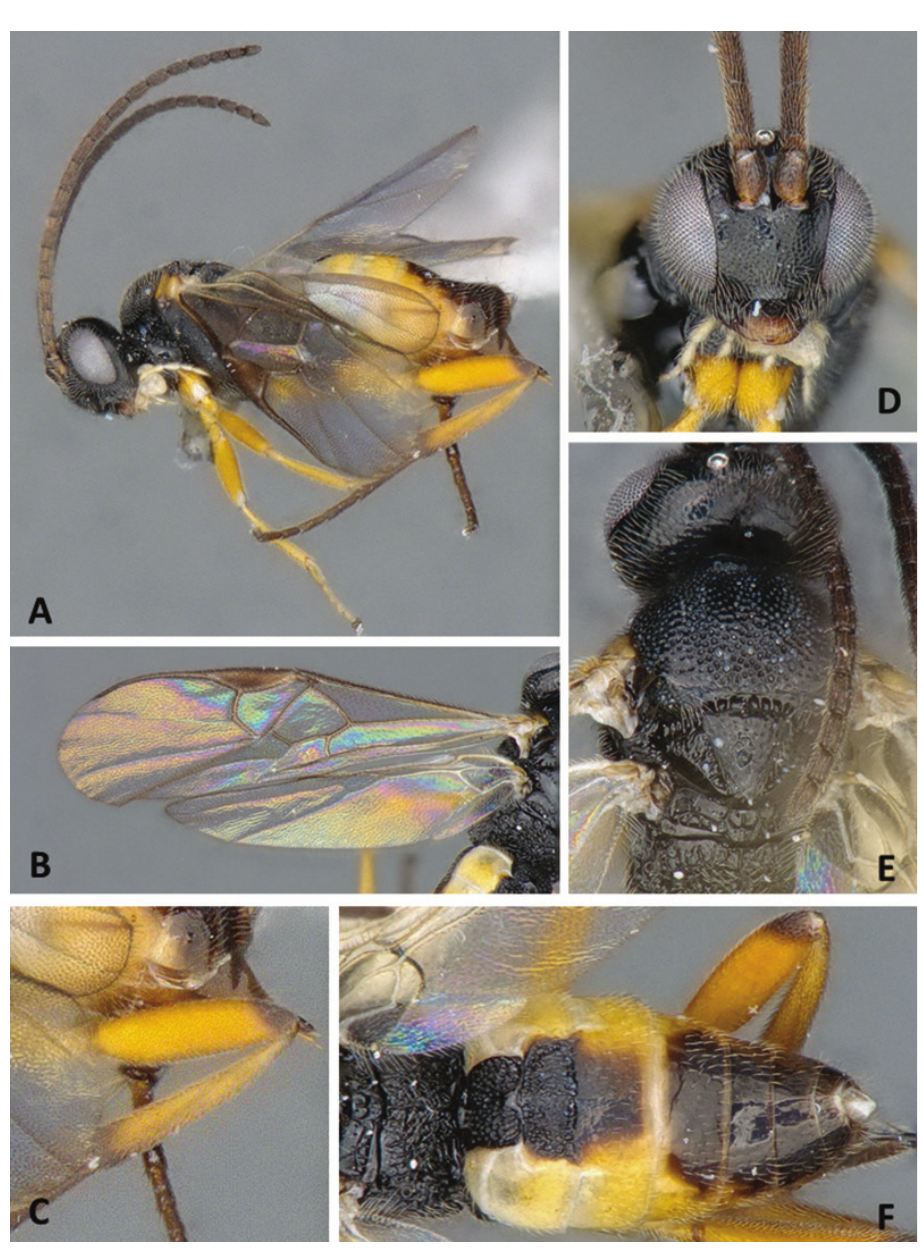
Figure 1. Cotesia icipe , female holotype. A Habitus lateral B Wings C Hind leg, hypopygium and ovi- positor D Head frontal E Head and mesosoma dorsal F Propodeum and metasoma dorsal.